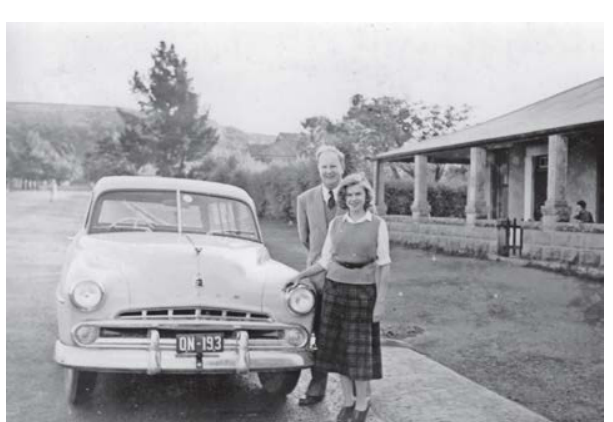
Figure 4: Mietek and Olénka in the 1950’s